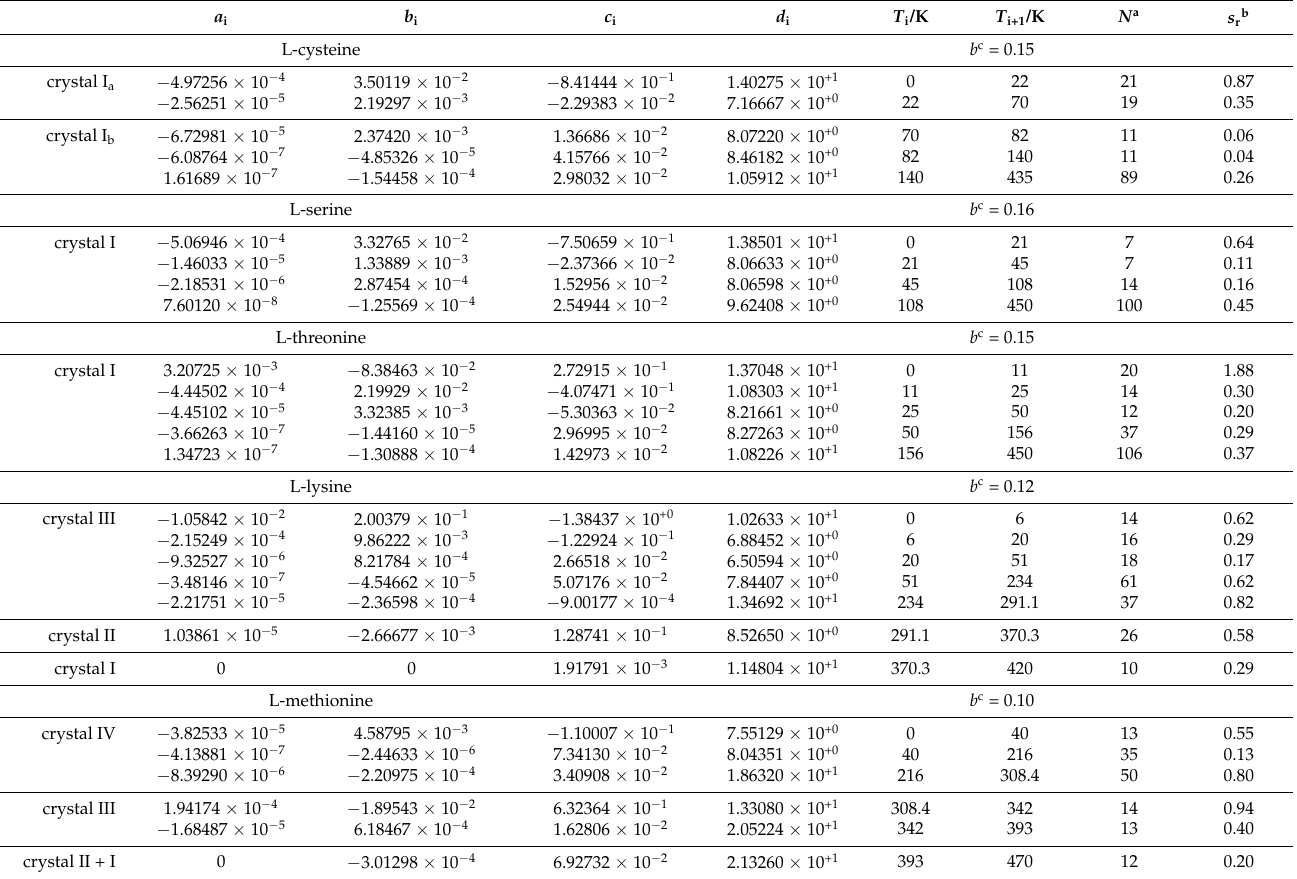
Table 5. Parameters of Equations (1) and (2) for Crystal Heat Capacities in J K − 1 mol − 1 .